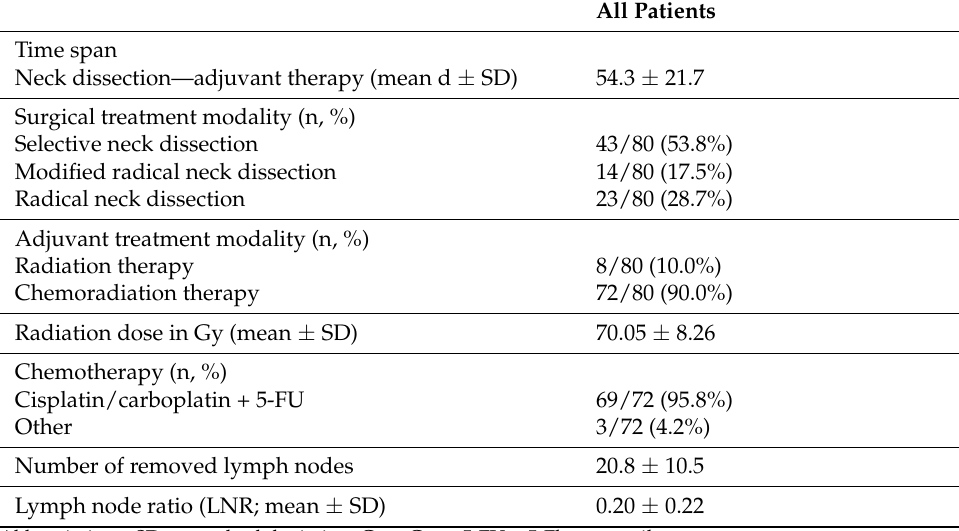
Table 2. Treatment characteristics.